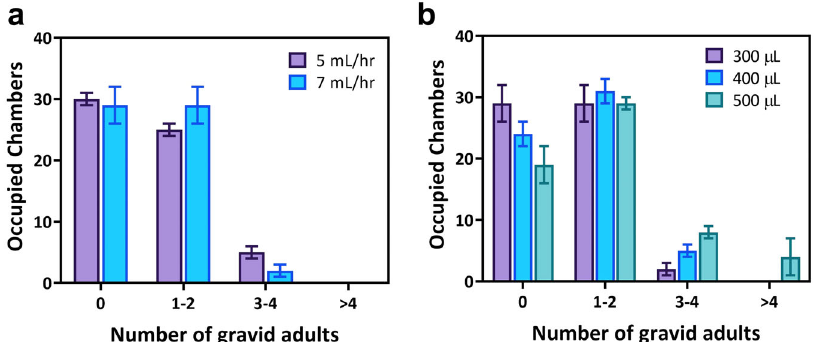
Fig. 6 Optimization of parameters used for ef fi cient loading of worms into NemaFlex-S device. a Effect of fl ow rate used for worm trapping in the tapered neck (Supplementary Table 3). b Effect of worm suspension volume (Supplementary Table 4). The density of animals in the culture bag was 1060 ± 160 adults/mL. Error bars represent standard deviation.